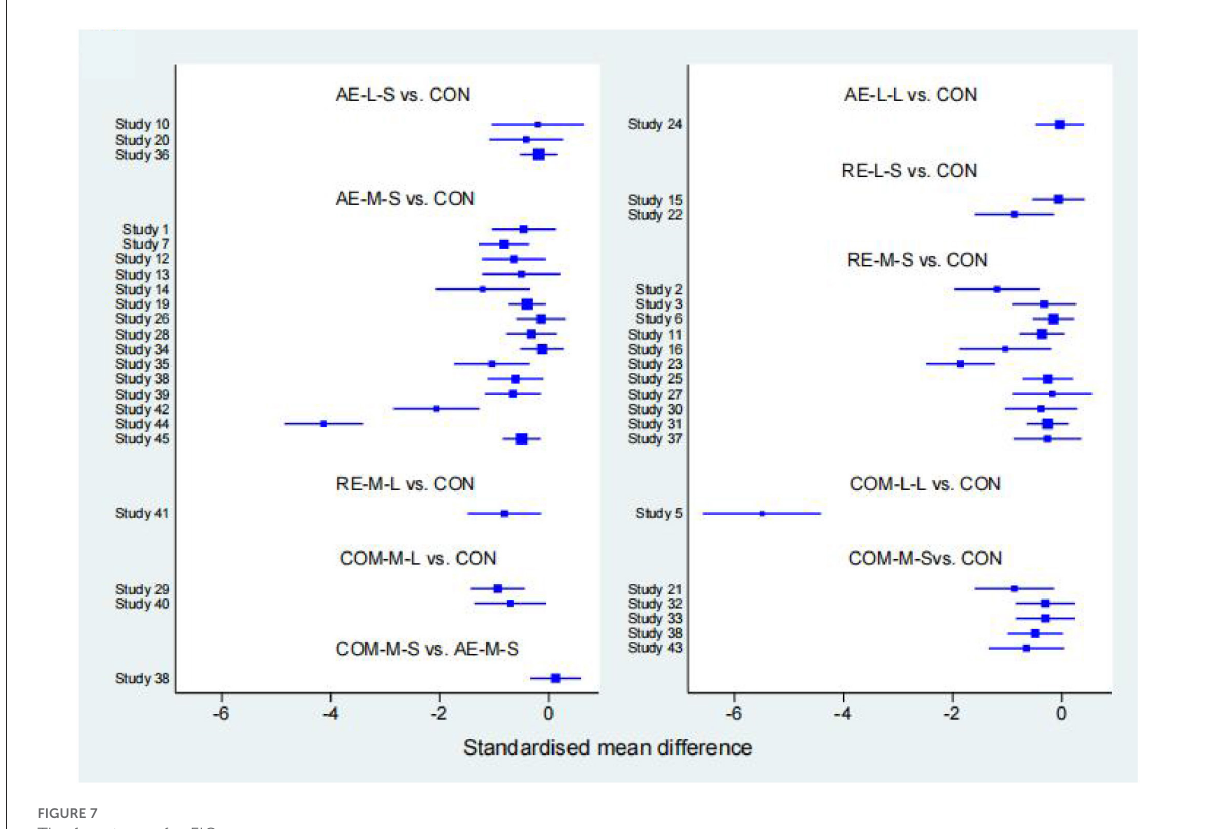
FIGURE7 The forest map for